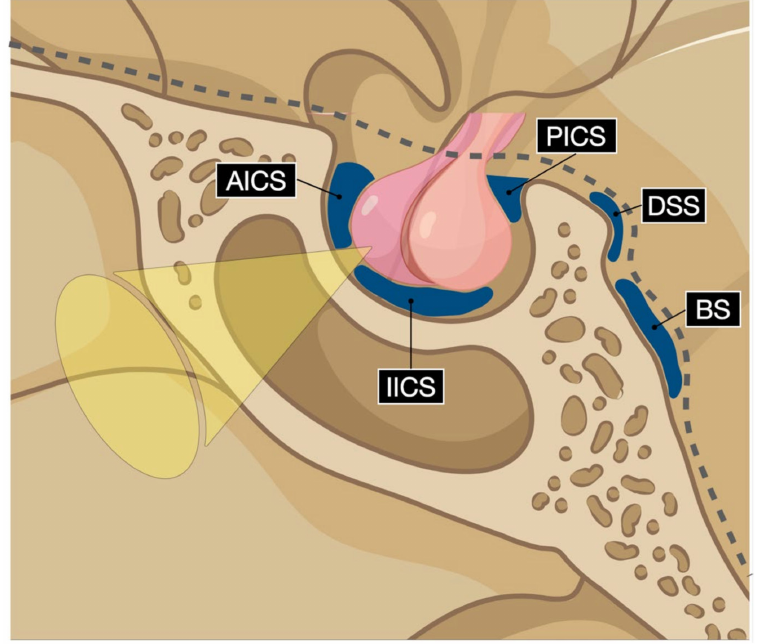
Figure 2. Digital drawing schematizes the intercavernous sinuses’ possible vascular pattern. AICS: anterior intercavernous sinus; IICS: inferior intercavernous sinus; PICS: posterior intercavernous sinus; DSS: dorsal sphenoid sinus; BS: basilar